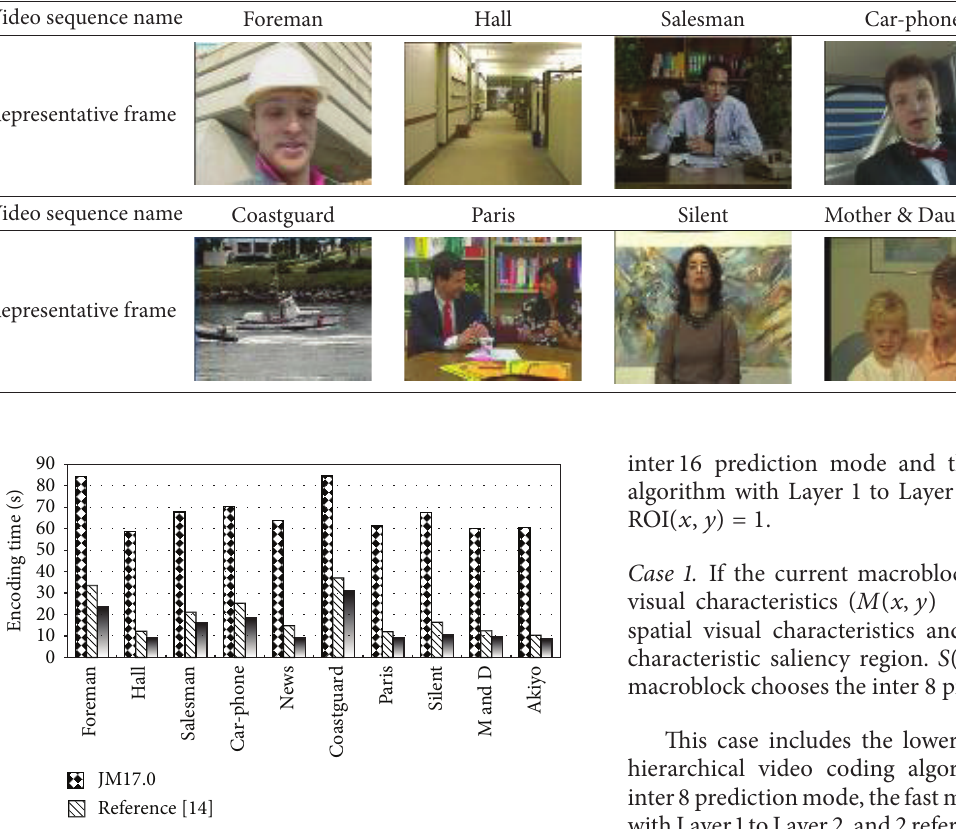
Table 3: The standard video sequence.